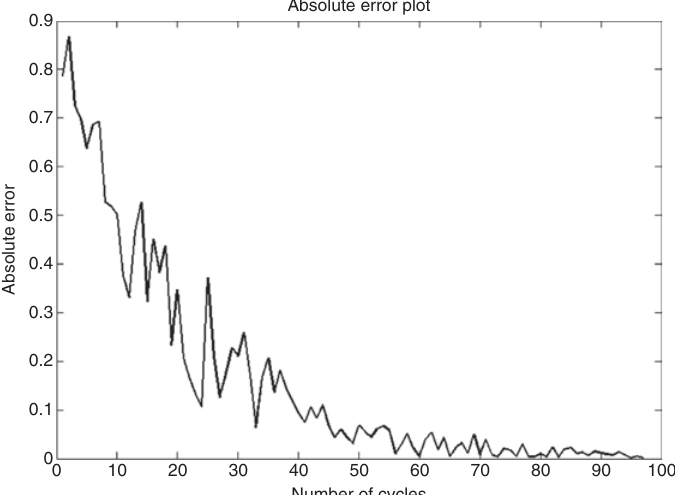
Figure 9: MSE Convergence Plot for Case 1.